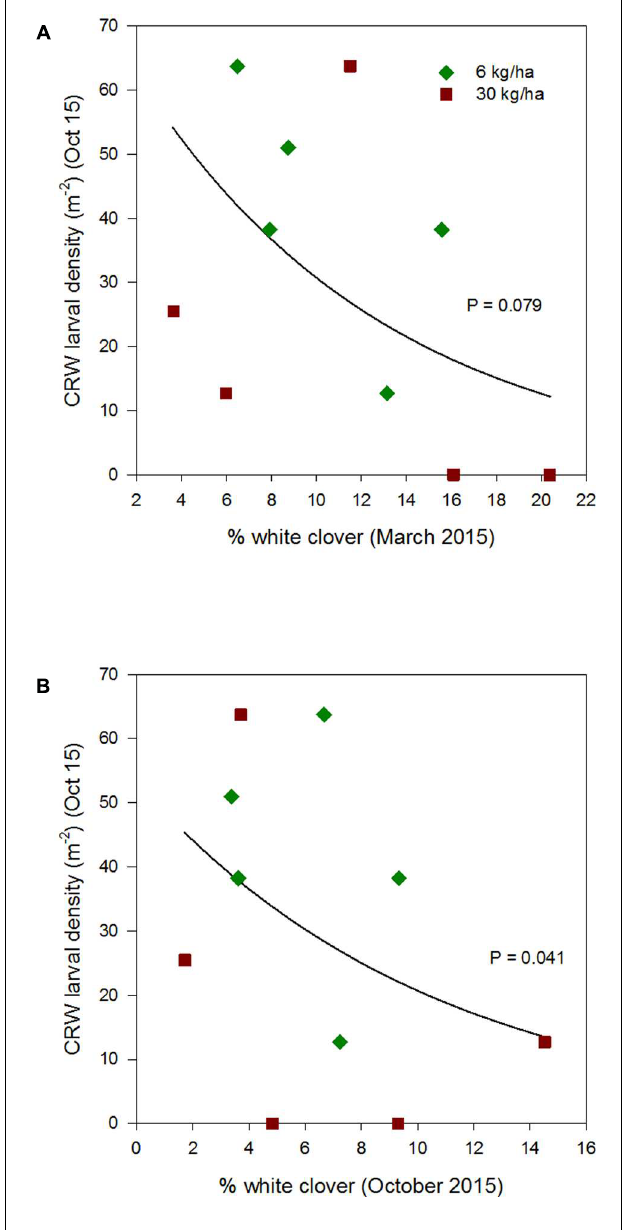
FIGURE 6 | Clover root weevil larval densities measured in October 2015 in relation to % white clover measured in March 2015 (A) and October 2015 (B), from ryegrass plots (cv. Nui) sown at 6 and 30 kg/ha (solid line shows the estimated relationship across all plots, irrespective of ryegrass sowing